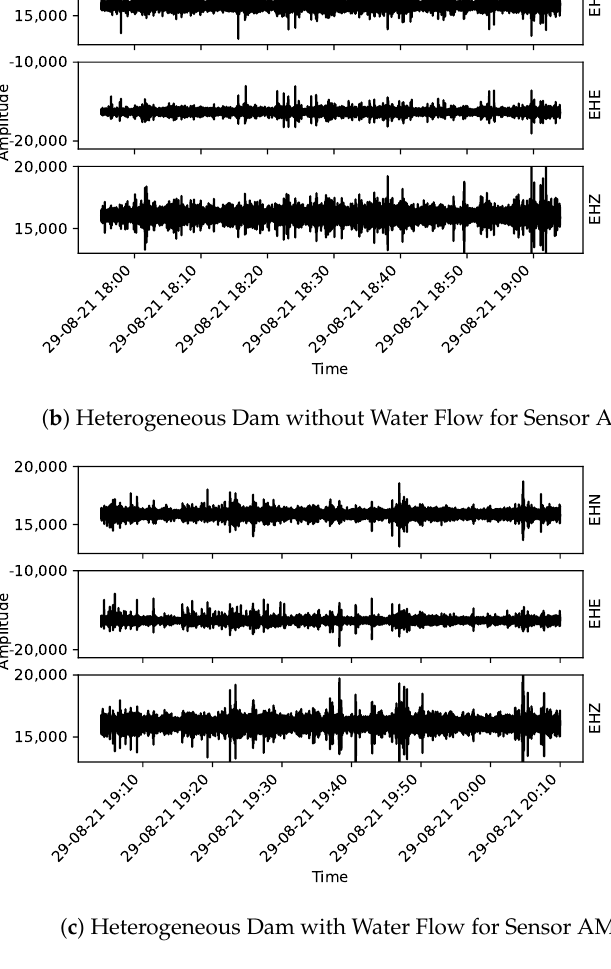
Figure 7. Collected data for sensor AM.RFBA7. From ( a ) to ( c ) the three monitoring stages are presented: homogeneous dam, heterogeneous dam without flow and heterogeneous dam with flow,